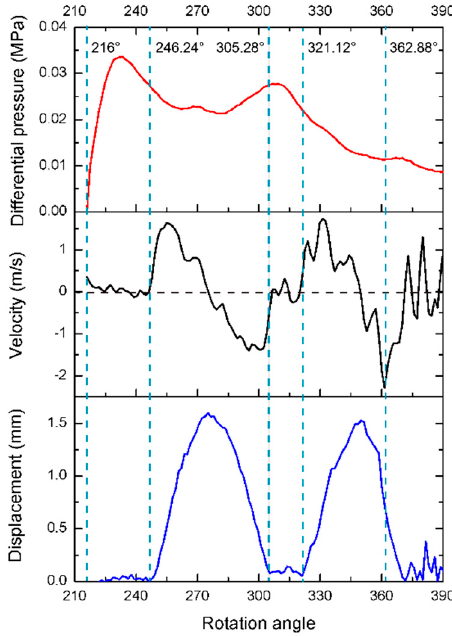
Figure 12. Suction valve motion.